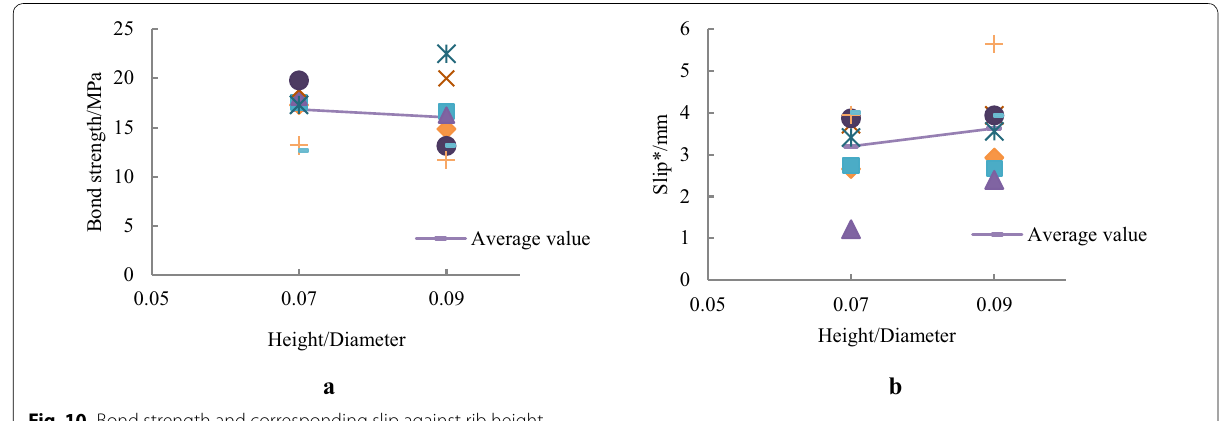
Fig. 10 Bond strength and corresponding slip against rib